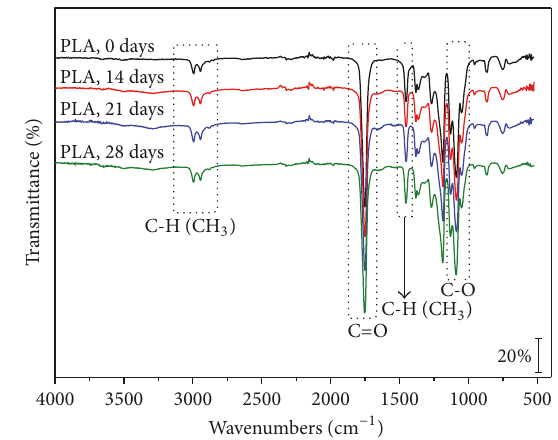
Figure 2: FTIR spectrum of PLA samples with different times of exposure in the animal body.